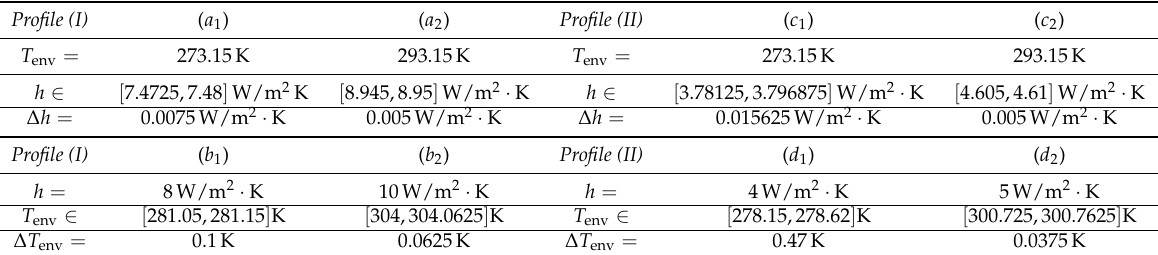
Table 4. Critical parameter intervals: Profile (I) (a) T env fixed, (b) h fixed, Profile (II) (c) T env fixed, (d) h